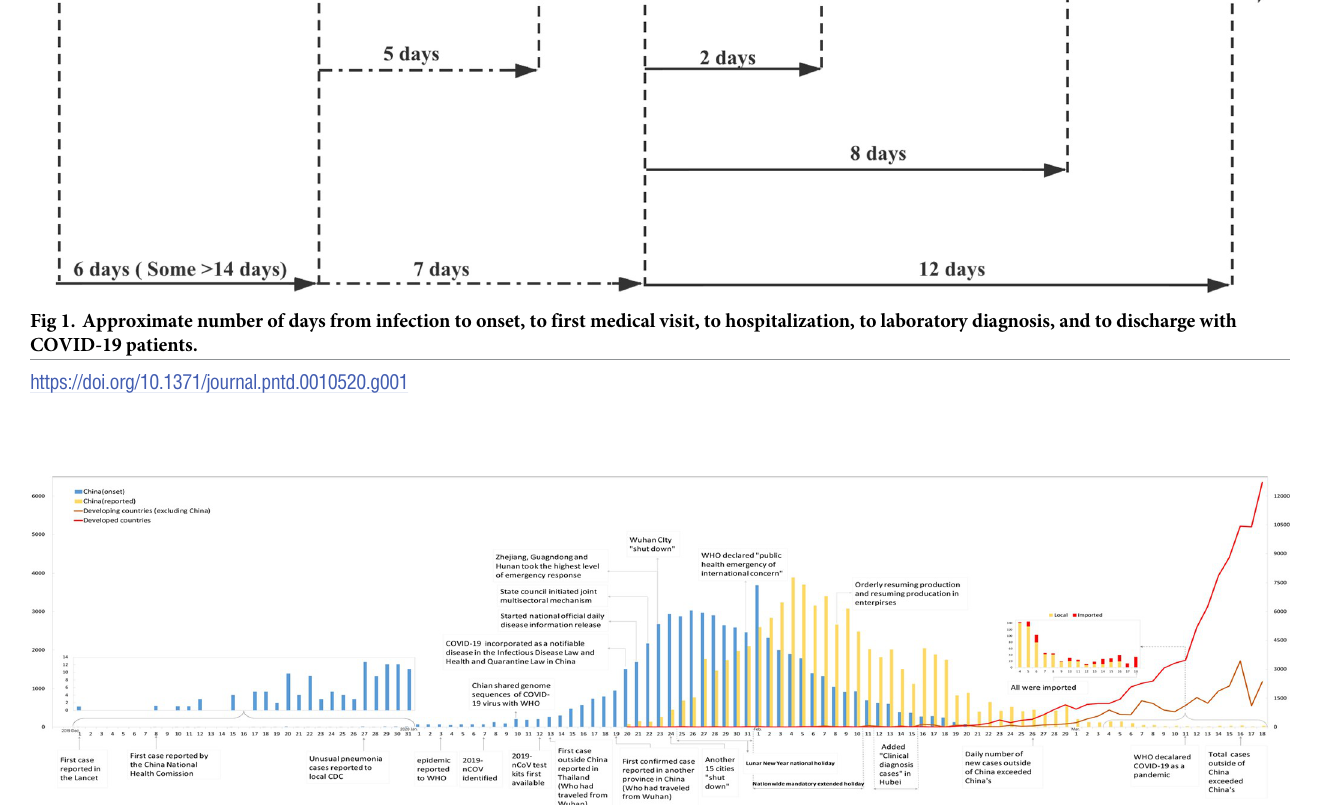
Fig 2. Epidemic curve of the confirmed cases of COVID-19 and time points of major related events.